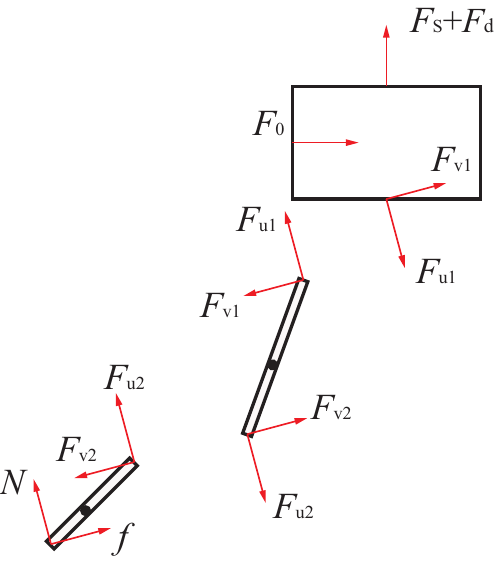
Figure A1. Free body diagram of the